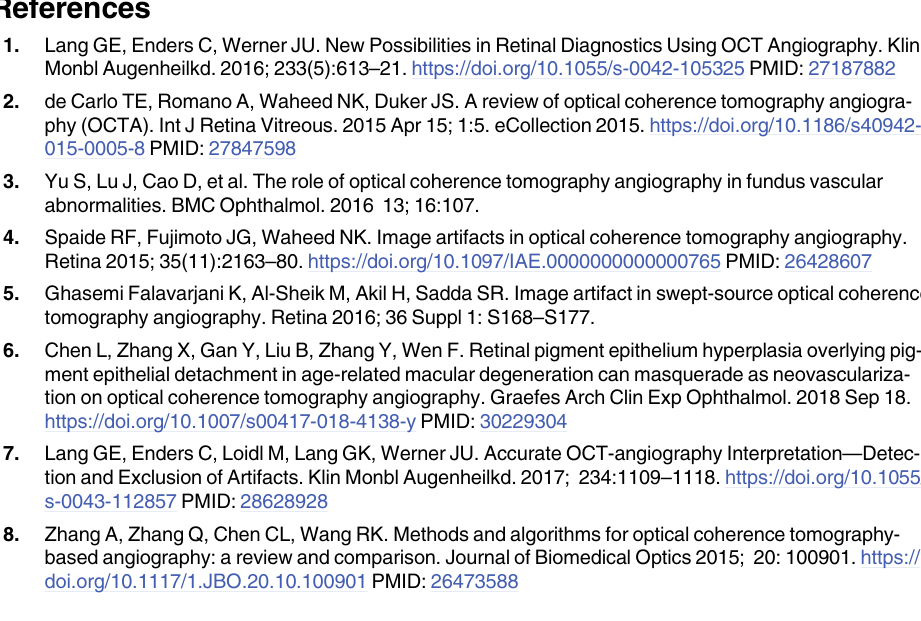
S1 Fig. More examples of OCTA artifacts. For each artifact OCTA enface and B-Scans are shown. Red arrows indicate the artifacts, red lines indicate the corresponding B-scan. (A) Pro- jection artifact. (B) Masking artifact. (C) banding artifact. (D) Blink artifact.